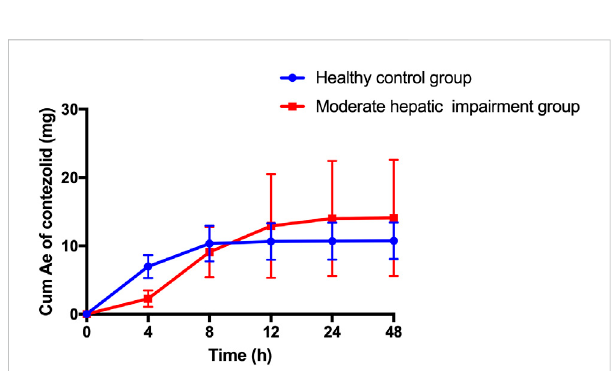
FIGURE 2 Mean (±SD) cumulative amount of contezolid excreted in urine following a single oral dose of contezolid 800 mg in patients with moderate hepatic impairment and healthy controls with normal liver function. SD, standard deviation; Cum Ae, cumulative amount of contezolid excreted in